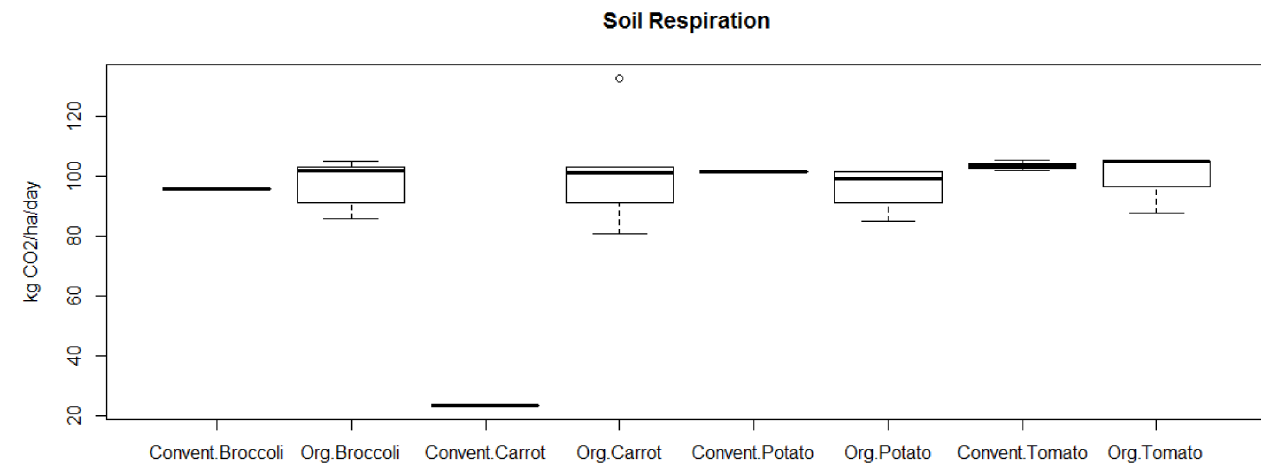
Figure 2. Boxplots showing alterations within crop systems and crop harvested in the